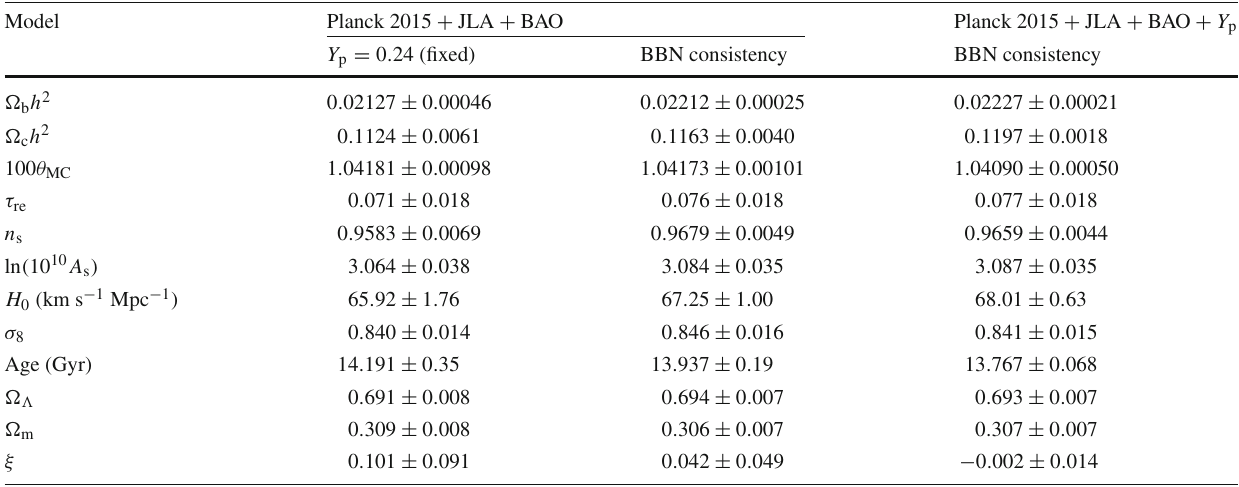
data, the JLA sample of Type Ia supernovae and the measurement of the helium-4 mass fraction. For comparison with BBN consistency, fixing Y p = 0 . 24 is also